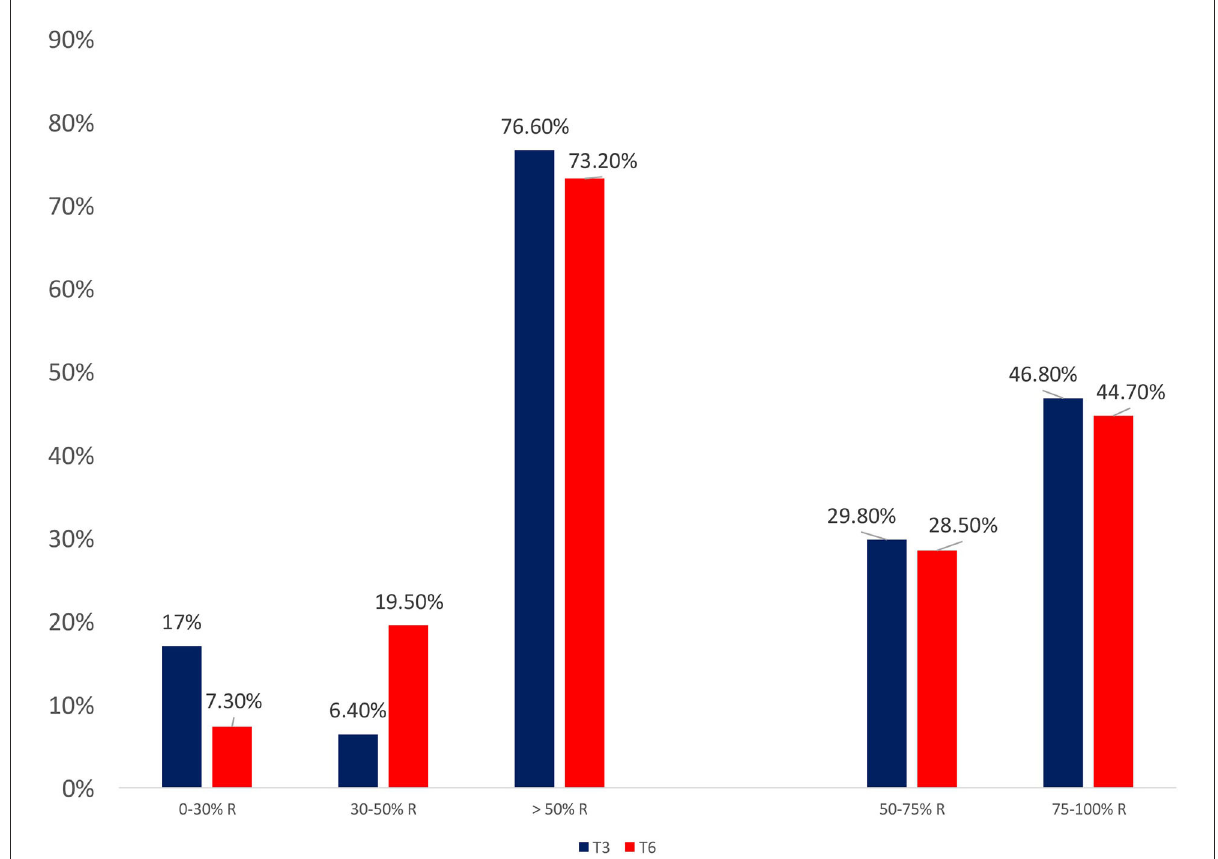
FIGURE2 Response patterns during treatment with galcanezumab, at three (T3) and six (T6) months of treatment.